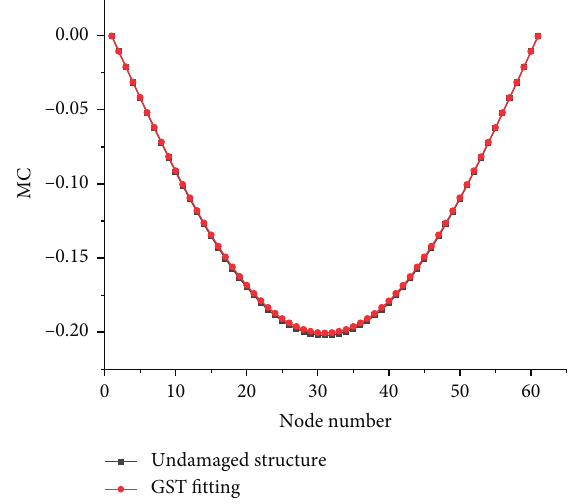
Figure 6: Gapped smoothing technique fitting.